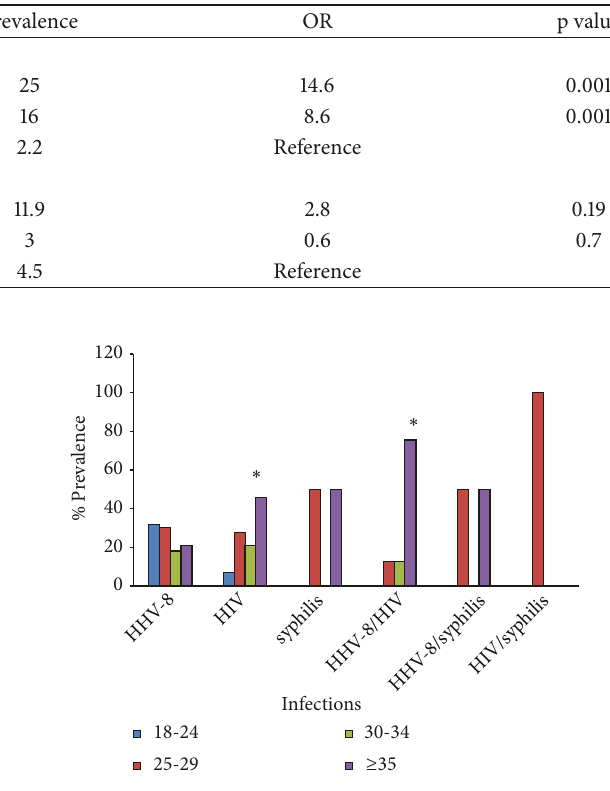
Figure 1: The prevalence of HHV-8, HIV and syphilis mono and co-infections among female sex workers in Malindi, Kenya in 2015- 2016.